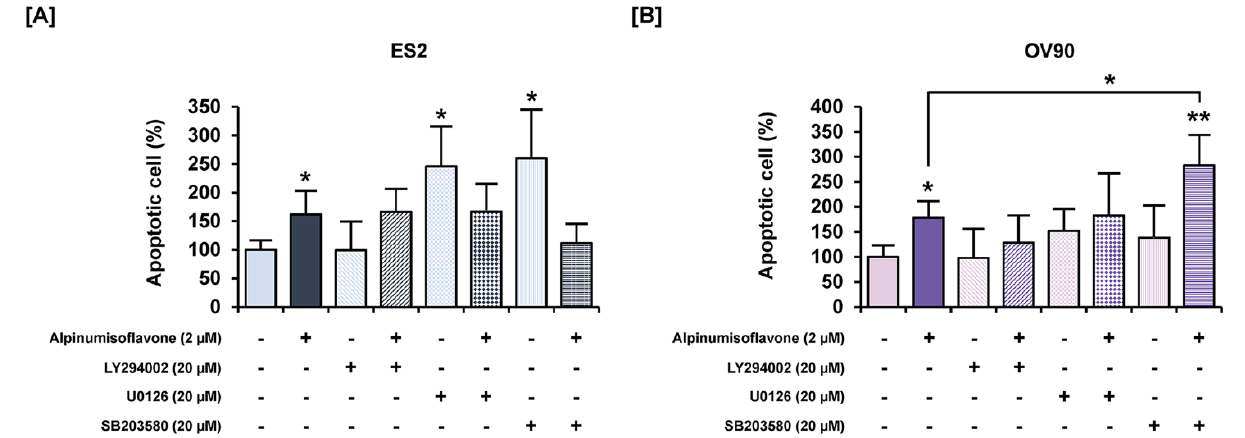
Figure 8. Effects of a combination of each inhibitor for PI3K, ERK1/2 and P38 MAPK pathways, with or without alpinumisoflavone, on apoptosis in ovarian cancer cells. ( A , B ) Apoptosis of ES2 ( A ) and OV90 ( B ) cells in response to LY294002, U0126 and SB203580, with or without alpinumisoflavone treatment for 48 h, was investigated using annexin V and PI. All experiments were performed in triplicate. The significance between the vehicle and treatment groups is depicted by asterisks (* p < 0.05 and ** p < 0.01).